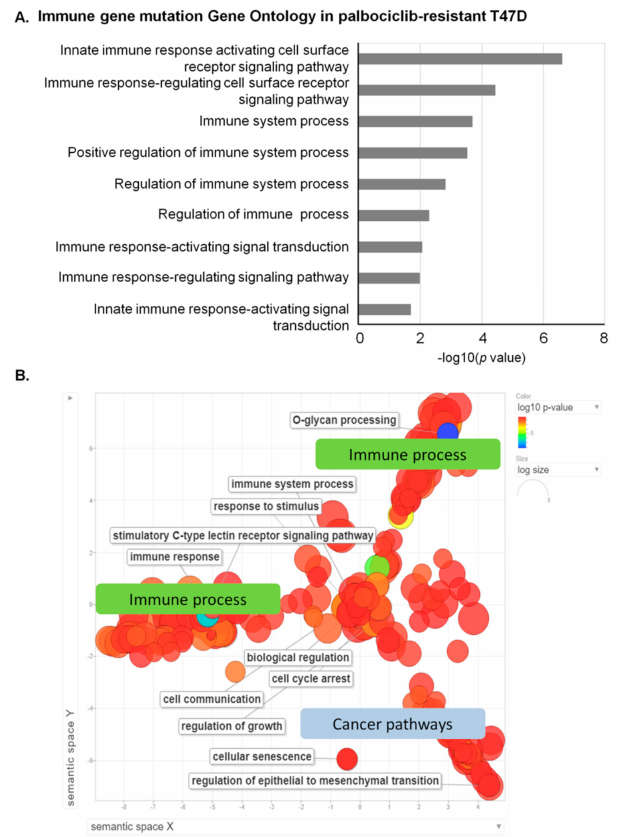
Figure 3. Mutation profiling in T47D or T47D-PR cells revealing immune pathway deregulation in palbociclib-resistant cells. ( A ) Mutations were identified according to the Genome Analysis Toolkit v3.4.0 following their best practice guidelines as described in the Methods section. The bar